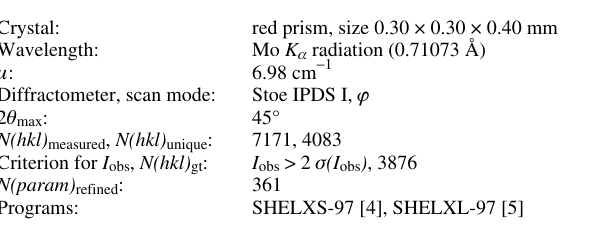
Table 1. Data collection and handling.